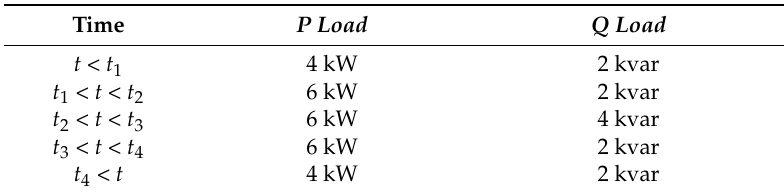
Table 4. Experiment sequence.